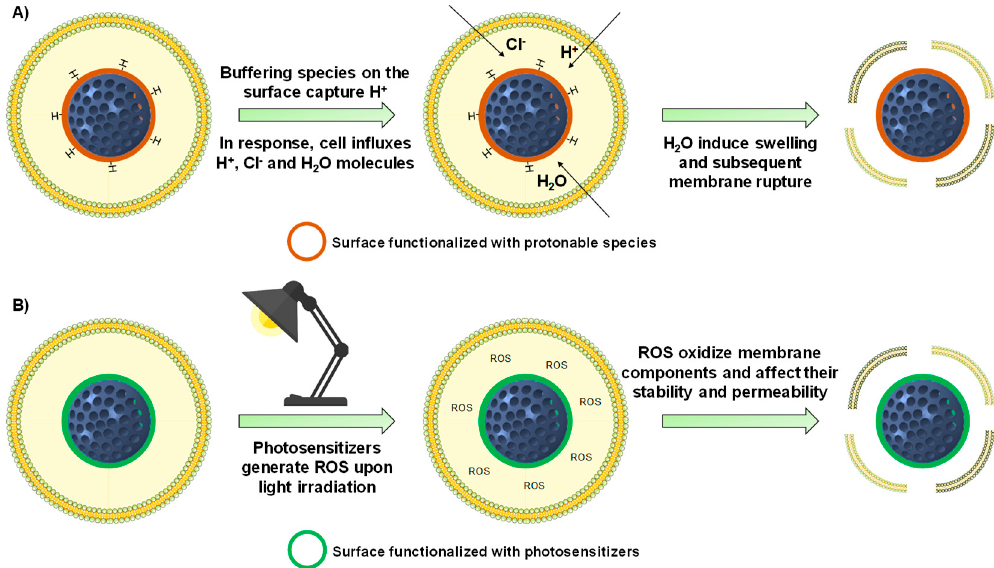
Figure 6. Schematic representation of the most employed strategies employed to induce the endosomal escape of MSNs. ( A ) The protonable species on the surface of the particles capture the protons of the vesicle. To counteract that basification, cell influxes protons, chloride ions and water, which induces the swelling and eventual endo-lysosomal rupture. ( B ) MSNs functionalized with photosensitizers are able to generate reactive oxygen species (ROS) upon light irradiation. These ROS can oxidize the lipid membrane of the endo-lysosomes, leading to a loss of stability and enhancement of the permeability of the lipid bilayer, triggering nanoparticle escape.